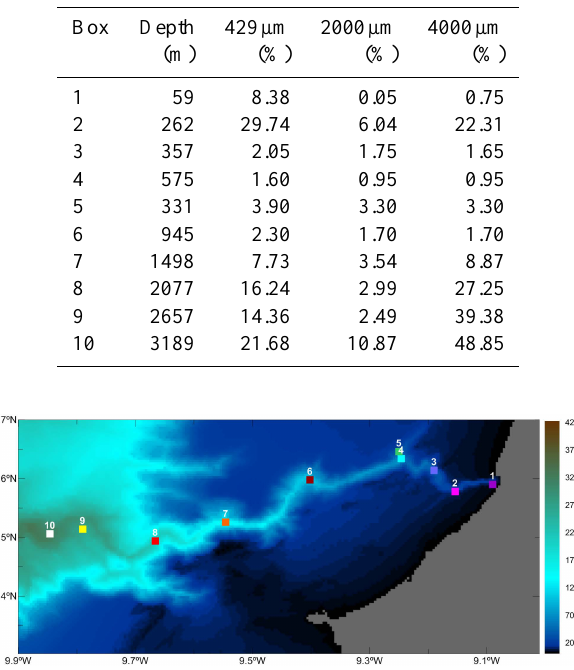
Fig. 2. Location of the 10 monitor boxes. The monitor boxes are set at increasing depths from box 1 to box 10: 59m, 262m,